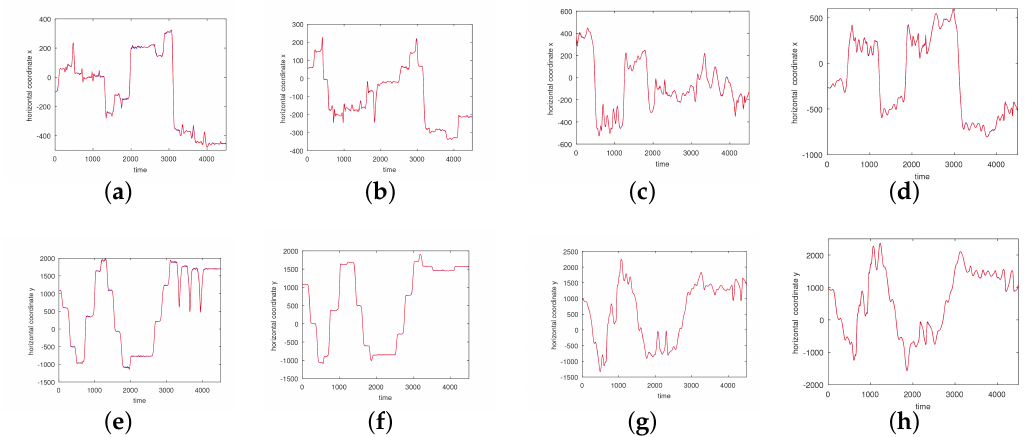
Figure 9. Approximations of x (left) and y coordinates (right) by 200 neurons and two centers for a simple non-segmented motion (sampled at 120Hz). The center frequencies are 0.30 Hz and 0.72 Hz. ( a ) Right heel , x -coordinate; ( b ) Left heel, x -coordinate; ( c ) Right wrist, distal, x -coordinate; ( d ) Left wrist, distal, x -coordinate; ( e ) Right heel , y -coordinate; ( f ) Left heel, y -coordinate; ( g ) Right wrist, distal, y -coordinate; ( h ) Left wrist, distal, y -coordinate. The red curves show the experimentally observed coordinates and the blue curves give their neural approximations. Both curves coincide up to pixel accuracy in many places.